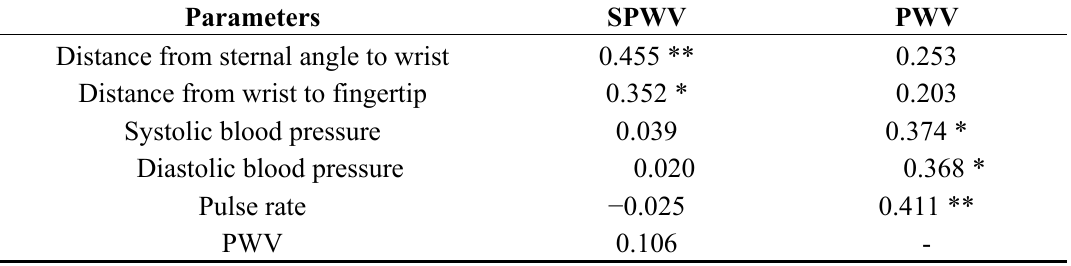
Table 2. Correlation Coefficients between SPWV and the Other Parameters (n =